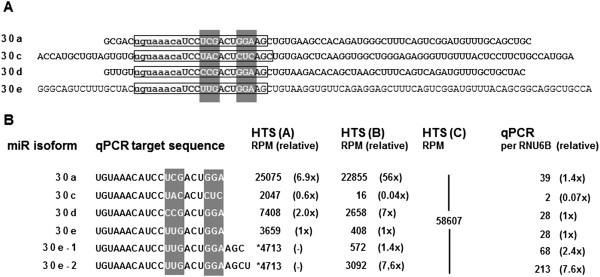
Isoforms of the hsa-miR-30 family. The hsa-miR-30 family comprises of a large number of overlapping mature miRNA sequences that might interfere with expression profiling. Mapping HTS reads to the human genome (pipeline A) detects 4 significantly overlapping sequences shown as hairpin sequences in A. Open boxes mark the sequences of mature 5′ miRNAs that were further validated. The sequence part that allows differentiation between the family members is marked in grey. The seed sequence common to all members is shown in lower case. (B) Currently, only high-throughput sequencing can clearly differentiate between hsa-miR-30 family members, additionally providing a chance to evaluate expression of hsa-miR-30e isoforms – 30e-1 and 30e-2. Means of miRNA expression in 20 samples using HTS data and qPCR for hsa-miR-30e-5p and interfering sequences (i.e. 30a, c and d) are listed. Although using specific forward and reverse primers for the detection of isoforms of the hsa-miR-30 family, qPCR that targets specific hsa-miR-30 family members clearly lacks specificity to detect 1 base changes in the target sequence. *- HTS pipeline A detection of the hairpin sequence for has-miR-30e. **- Pipeline C generates a sum of all isoforms with the same seed sequence.